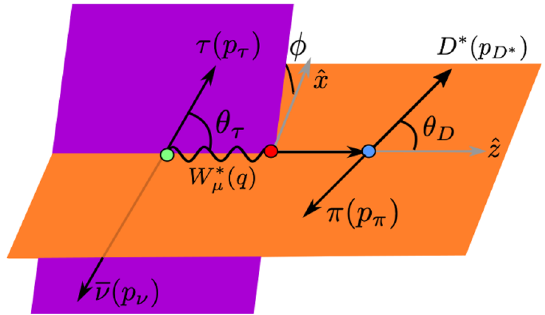
Figure 1 . Schematic representation of the kinematical variables for the B ! D (cid:3) ( ! D (cid:25) ) (cid:28) (cid:22) (cid:23) process.